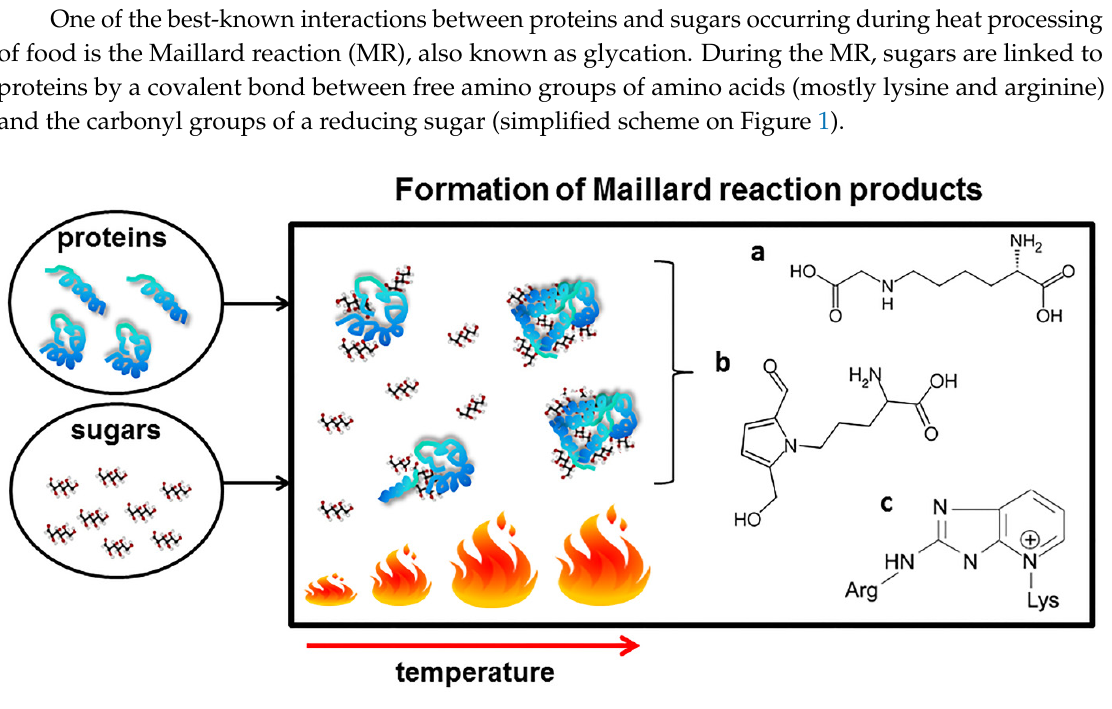
Figure 1. Simplified scheme of the formation of Maillard reaction product during food processing. Amadori rearrangement leads to the formation of a number of advanced glycation end products, among others: (a) N ε -(carboxymethyl)lysine; (b) pyrraline and (c) pentosidine .